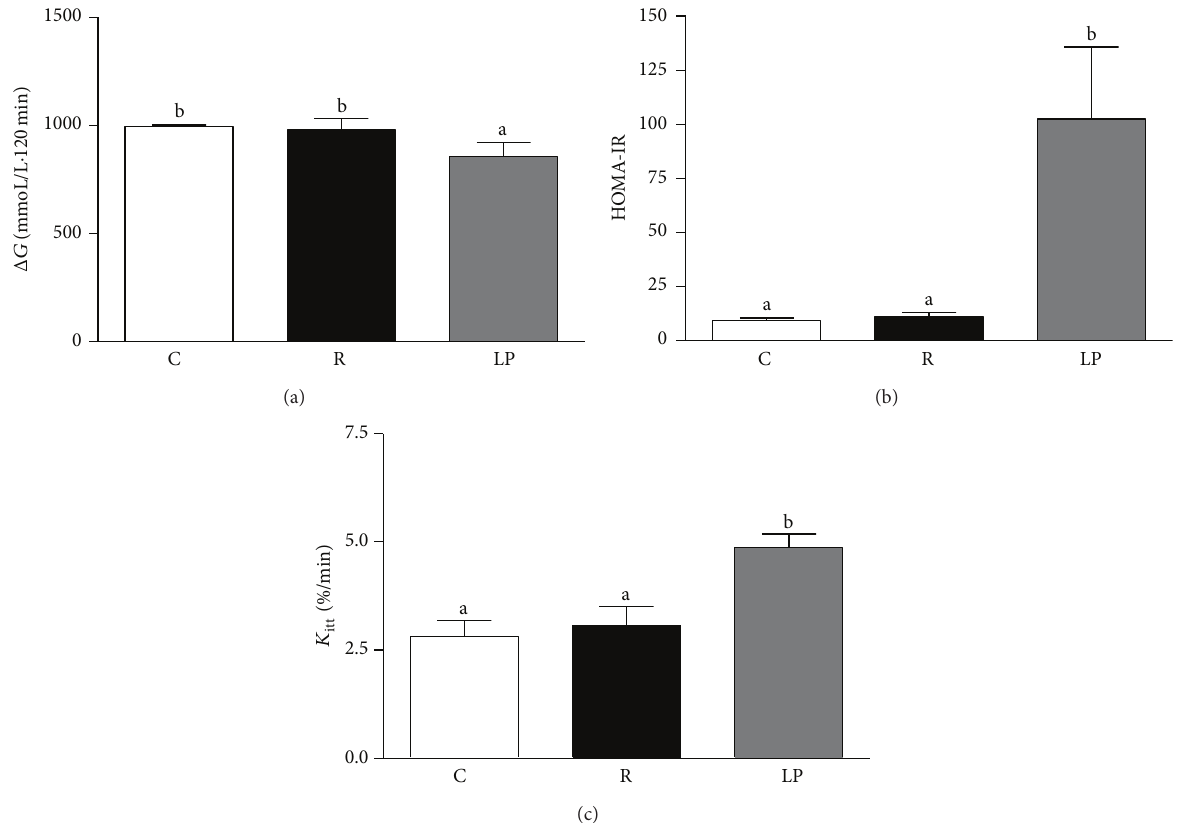
Figure1:Totalareasundertheglucose( Δ𝐺 )curveobtainedfromtheintraperitonealglucose-tolerancetest(a),homeostasismodelassessment ) (c) in control (C), recovered (R), and low protein (LP) rats. of insulin resistance (HOMA-IR) index (b), and glucose disappearance rates ( 𝐾 itt The bars represent means ± SEM. Mean values with unlike superscript letters were significantly different ( 𝑃 < 0.05 , LSD